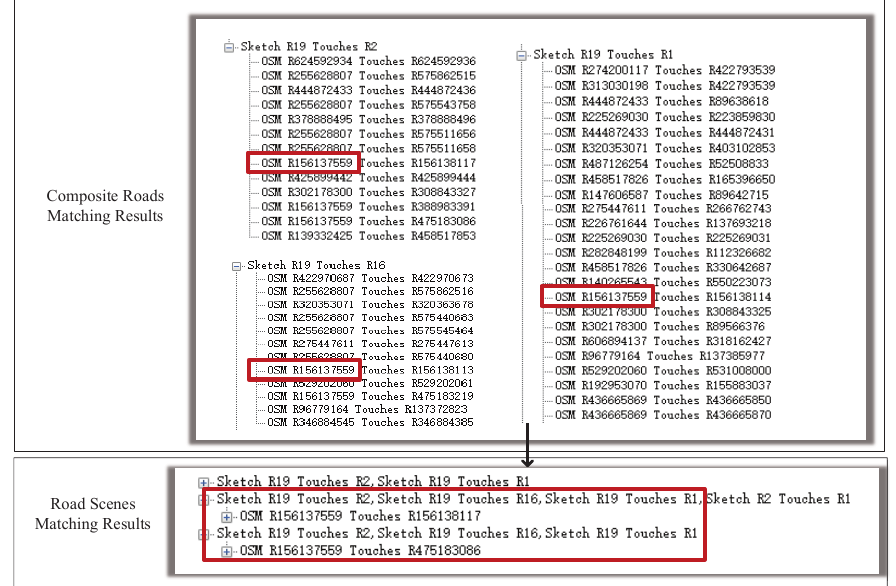
Figure 13. R156137559 appears in all the composite road matches. The first level of each tree view in the resulting composite road matches represents each composite road from the sketch. The child nodes represent the matched composite roads from OSM sorted according to the roads’ similarities to the parent composite road from the